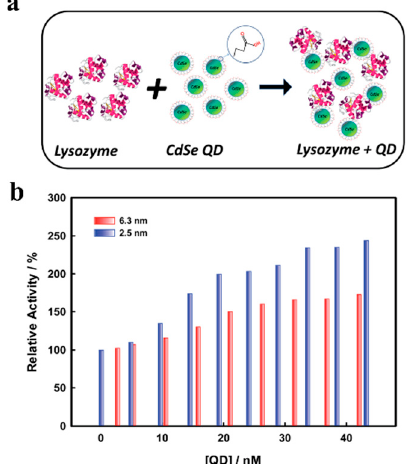
Figure 7. E ff ect of QD size on enzymatic enhancement of lysozyme. ( a ) Schematic of absorption of lysozyme on CdSe QDs. ( b ) E ff ect of concentration of QDs (2.5 to 52.5 nM) of sizes 2.5 nm and 6.3 nm on the enzymatic activity of lysozyme (5 µ M). Reproduced (Adapted) from Ref. [108] with permission from The Royal Society of Chemistry, London, United Kingdom.